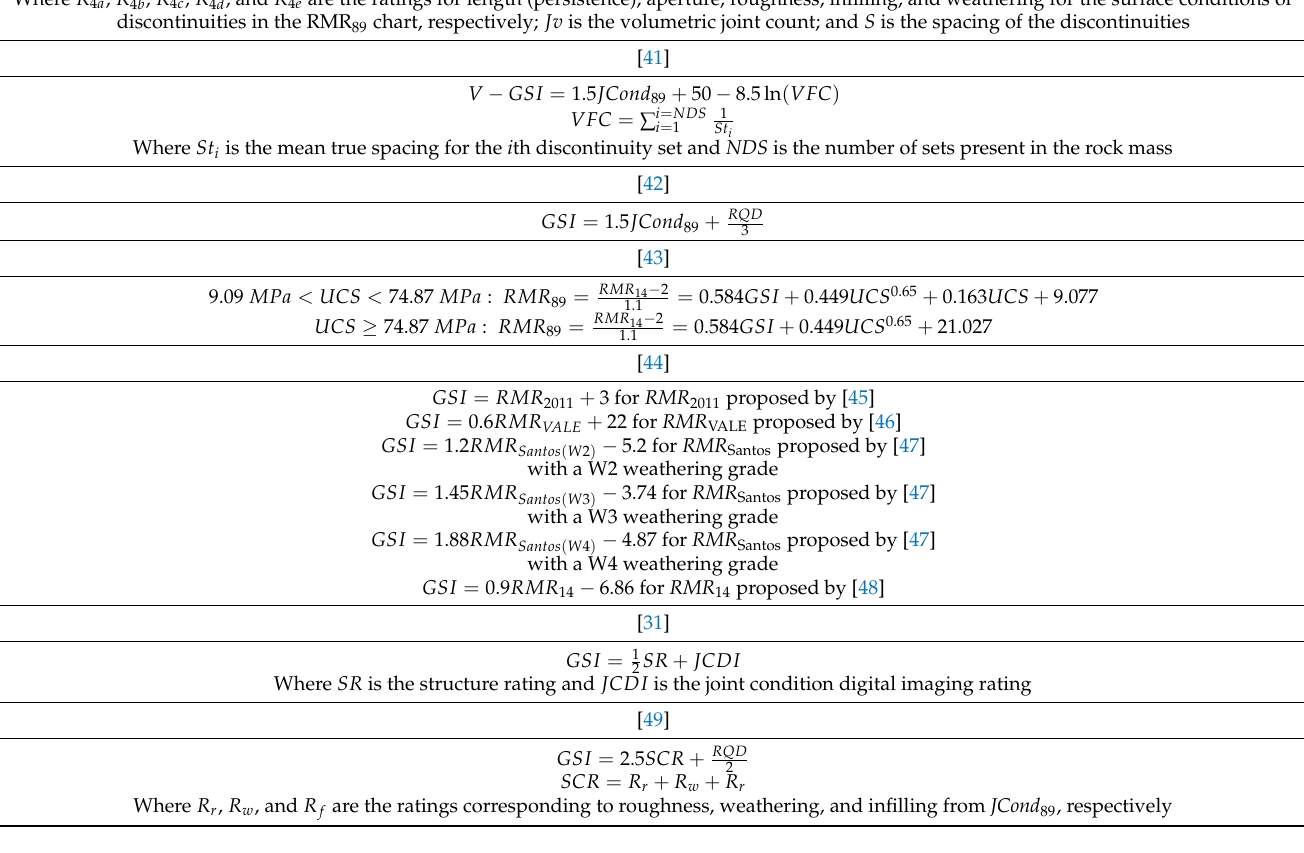
Table 4. Proposed GSI quantifications